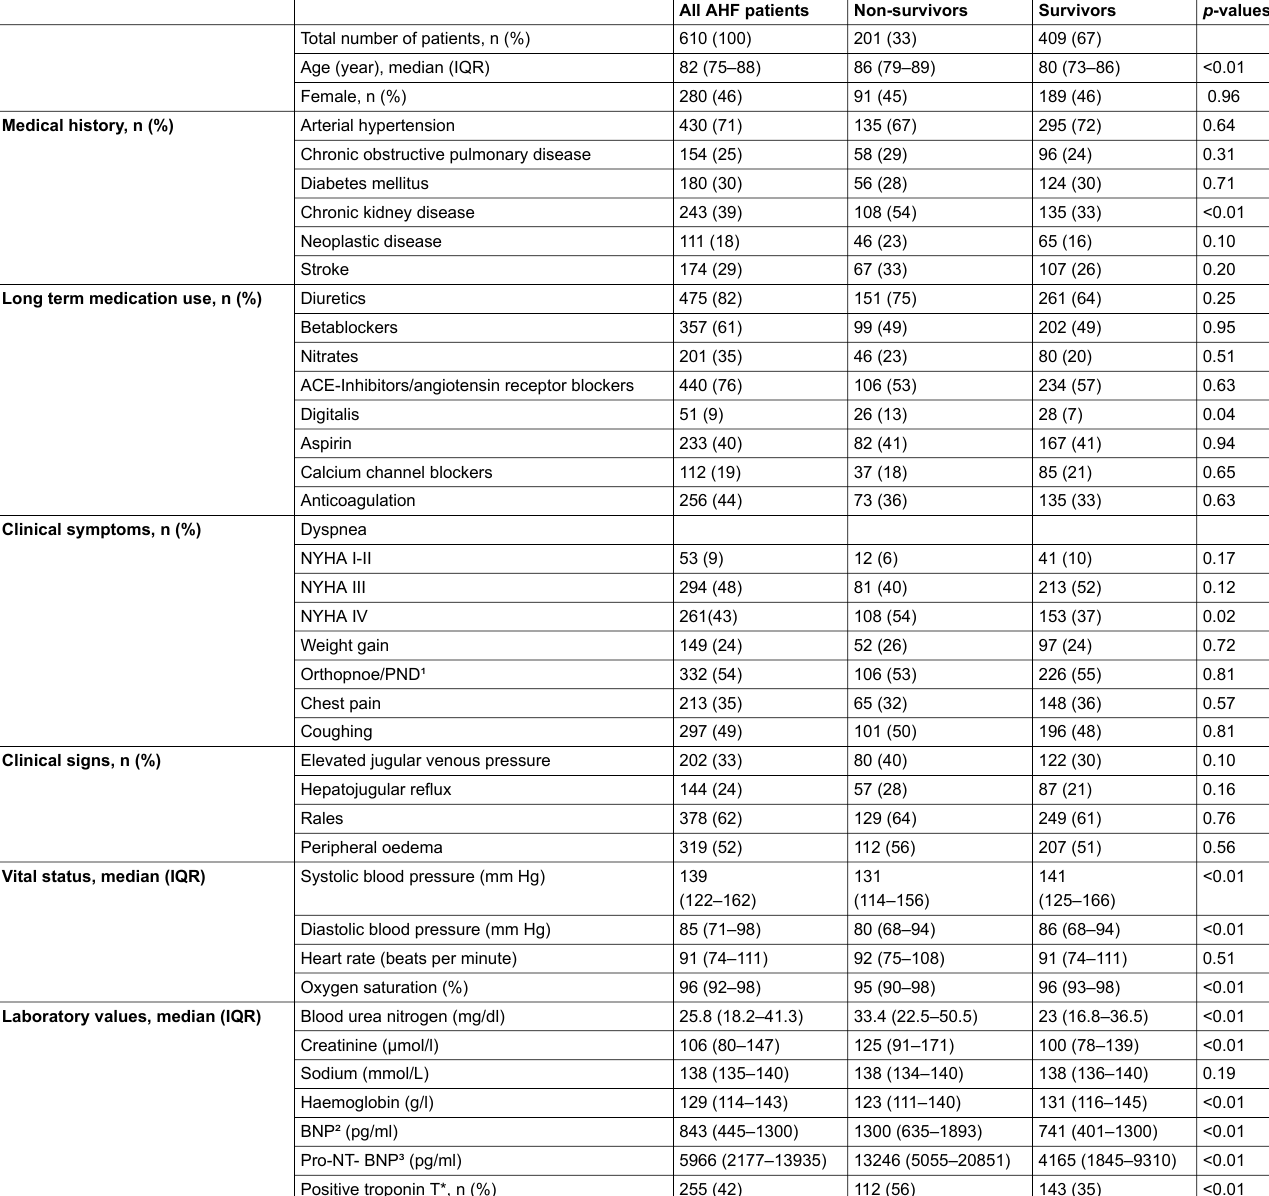
Table 1: Demographic and clinical characteristics of all AHF patients. ¹= Paroxysmal nocturnal dyspnea, ² B-type natriuretic peptide, ³ N-terminal pro-B-type natriuretic peptide; Data are presented as median (interquartile range), number of patients (%) or mean ± SD. *positive troponin T ≥0.04